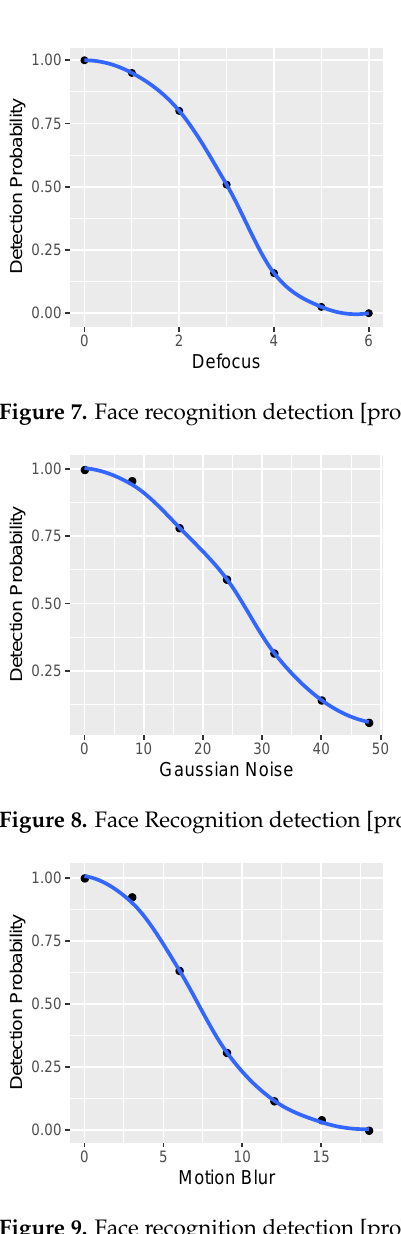
Figure 9. Face recognition detection [probability] for motion blur [ σ /degrees].